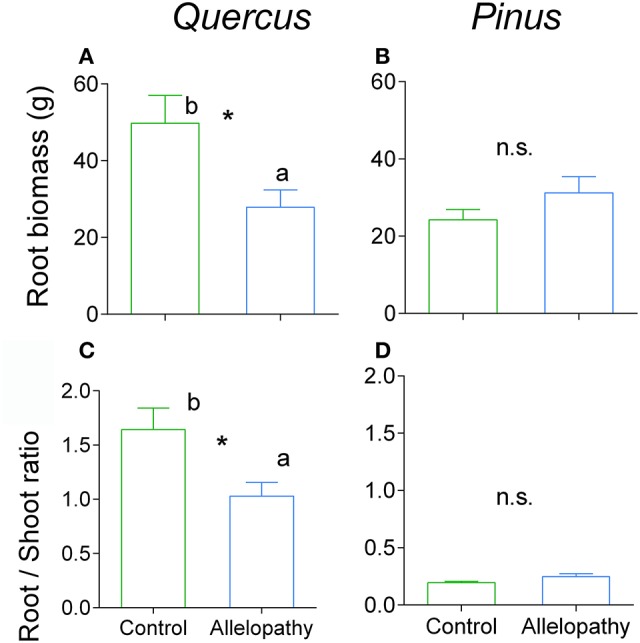
Effects of allelopathic treatment in belowground biomass and allocation. Belowground biomass in Quercus (A) and Pinus (B) and belowground allocation in Quercus (C) and Pinus (D) in Control (green bars) and Allelopathy (blue bars) treatments. Bars are means ± SD (5 ≤ n ≤ 8). Different letters indicate a significant difference between control and allelopathy treatments at P < 0.05 (*).